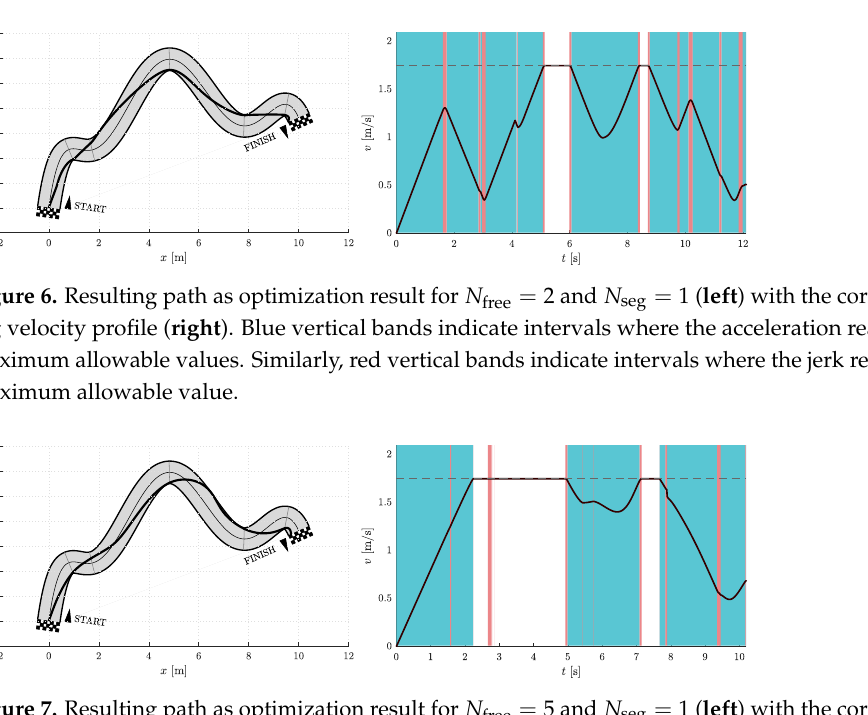
Figure 7. Resulting path as optimization result for N free = 5 and N seg = 1 ( left ) with the correspond- ing velocity profile ( right ). Blue vertical bands indicate intervals where the acceleration reaches its maximum allowable values. Similarly, red vertical bands indicate intervals where the jerk reaches its maximum allowable